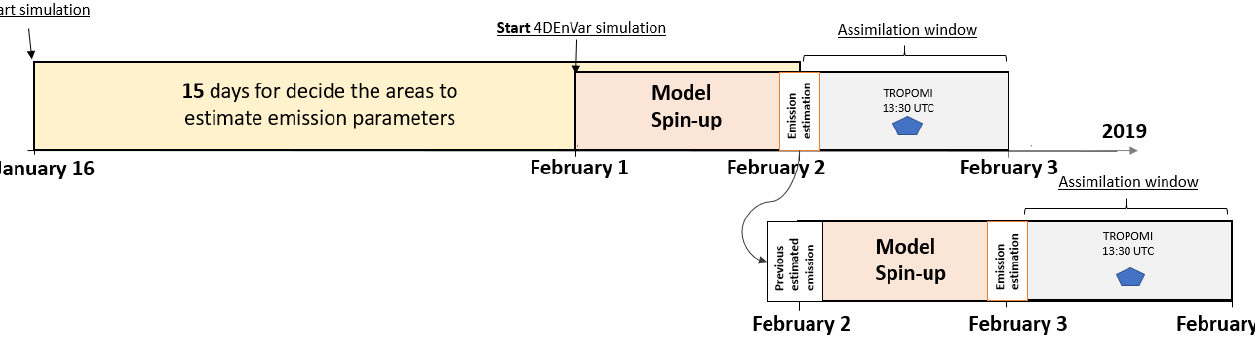
Figure 2. Data assimilation (4DEnVar) procedure for emission parameter estimation. Simulations were run for 15 days (16–31 January) prior to the start of the data assimilation process. In the window 1–3 February, the ensemble was propagated without assimilation and in this new ensemble space the assimilation was performed for 2–3 and 3–4